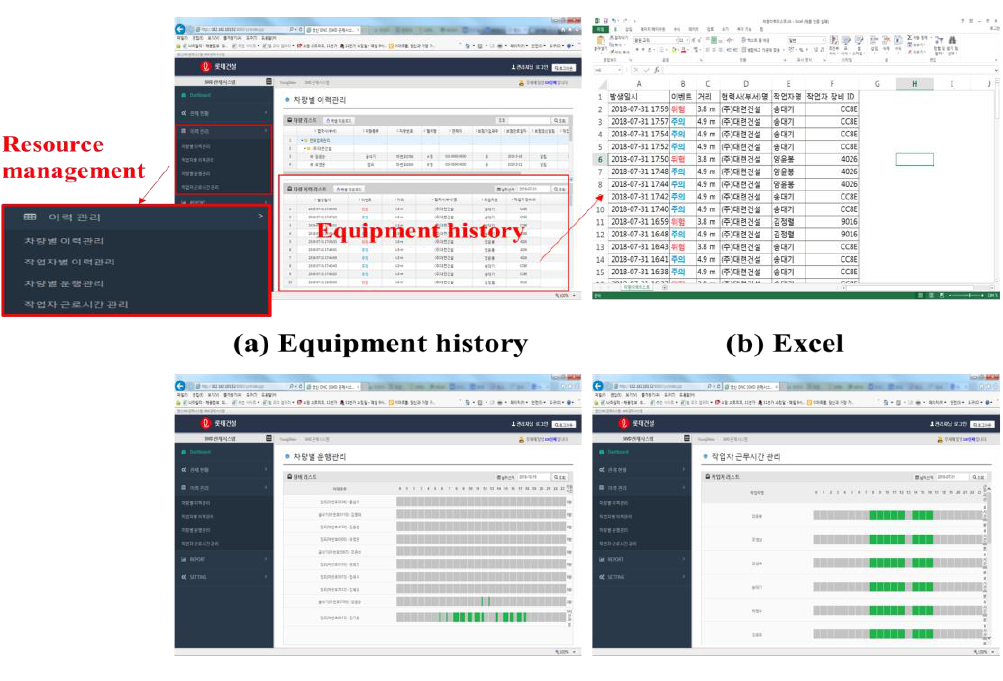
Figure 19. Real-time monitoring.